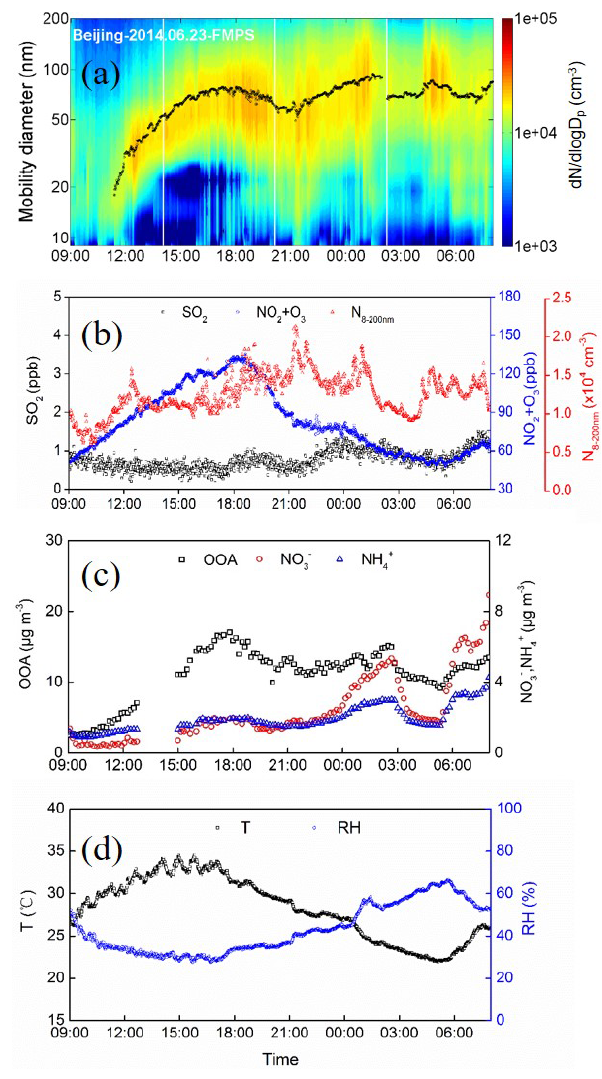
Figure 5. NPF event on 23 June 2014. (a) Contour plot of particle number concentration. (b) Time series of observed mixing ratios of SO 2 , NO 2 + O 3 , and N 8 − 200nm . (c) Time series of observed OOA, NO − , and NH + in PM 1 . 0 . (d) Time series of ambient T and RH. 3 4 Please note that the date format used in this figure is year month day